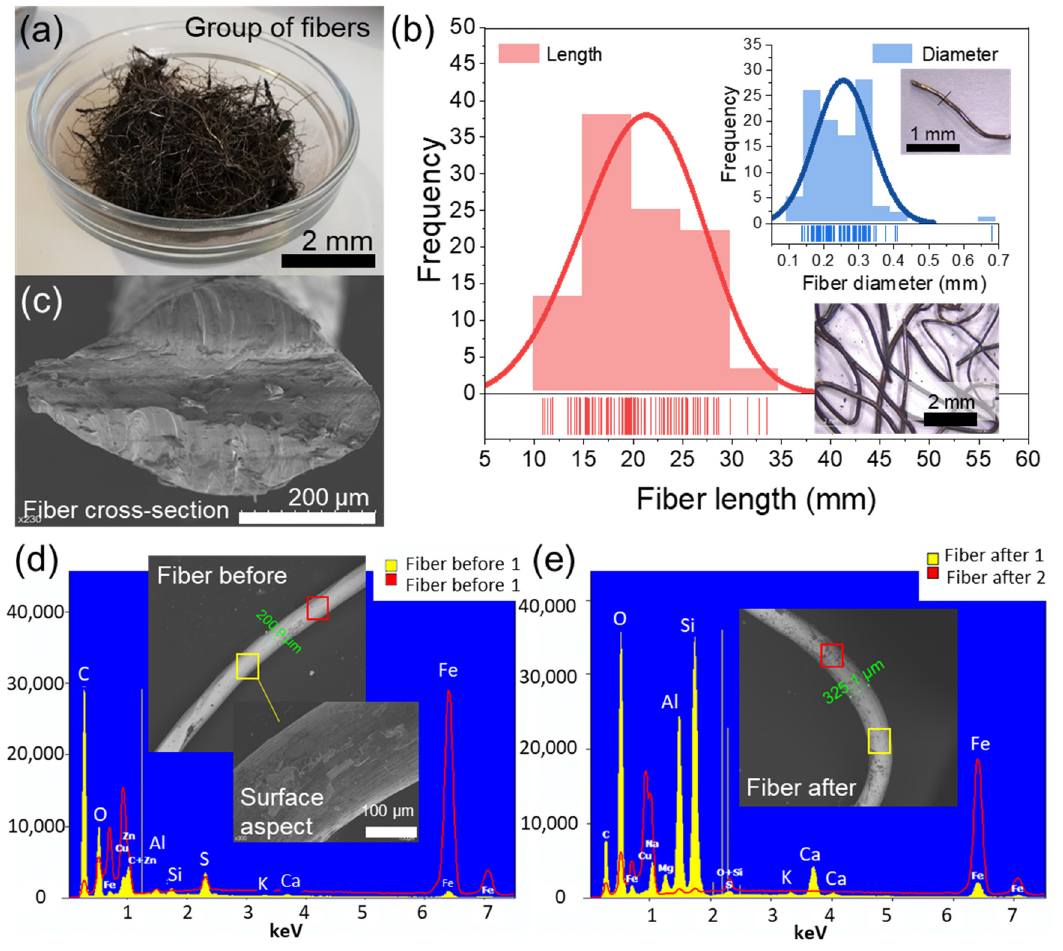
Figure 1. Characterization of metallic fiber from recycled tires: ( a ) group of fibers; ( b ) ESEM image of the cross-section of the cutting fiber; ( c ) frequency histogram of the length and diameter of fibers data with Weibull and normal fitting respectively; ( d ) ESEM-EDX elemental analysis of the fibers before and; ( e ) after manufacturing indicates more mineral residue and oxidation after the mixing process.